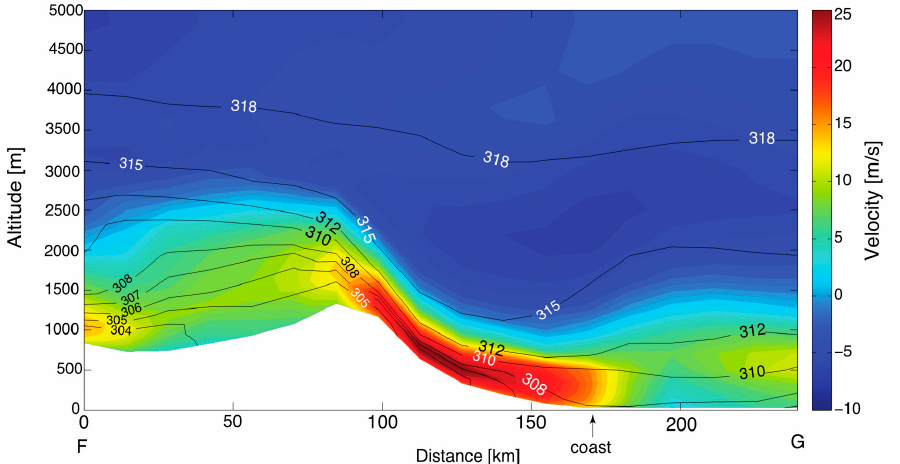
Figure 6. Horizontal, along-section wind velocity (colors) and potential temperature (contours) along the path FG of the downslope flow through Gap 2 (indicated on Figure 1) at 05 UTC on 12 July 2008.